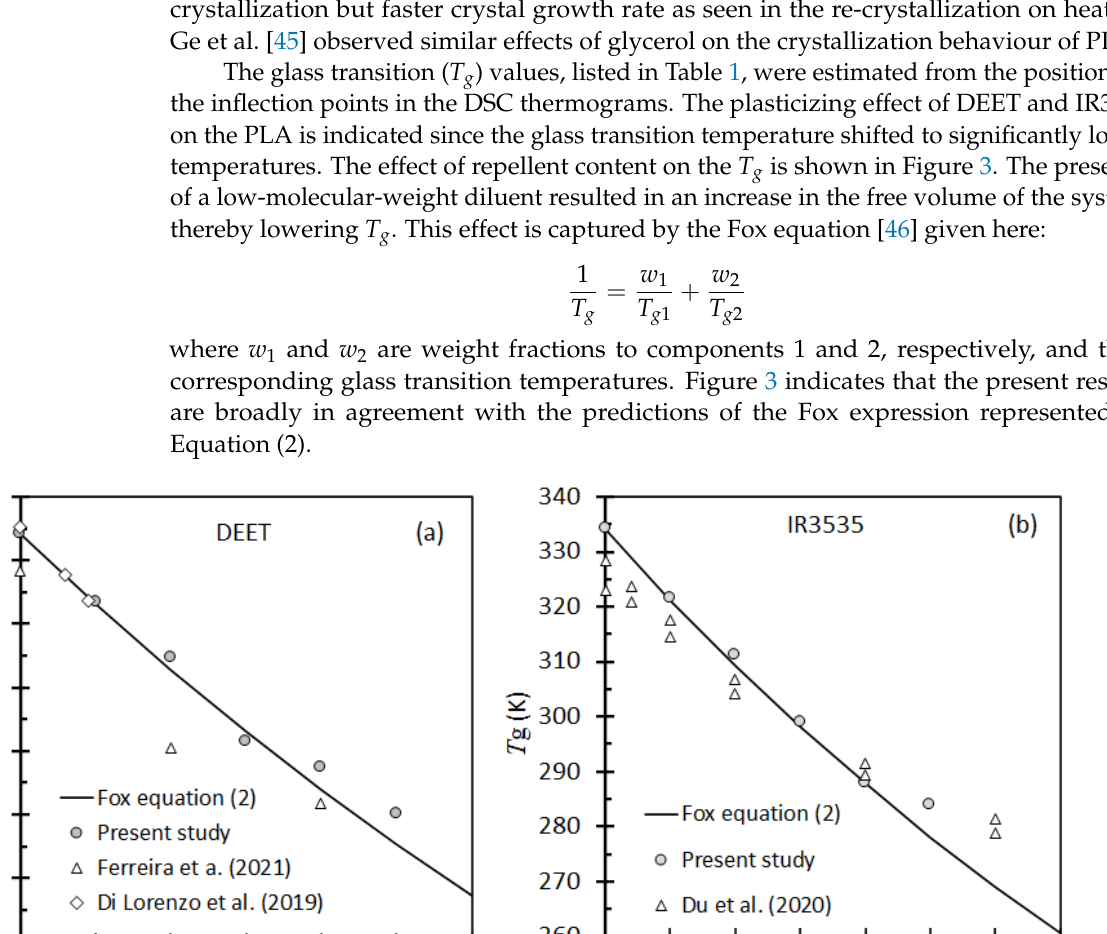
Table 1. DSC Parameters obtained for neat PLA, PLA/DEET and PLA/IR3535 blends. Repellent (wt.%)